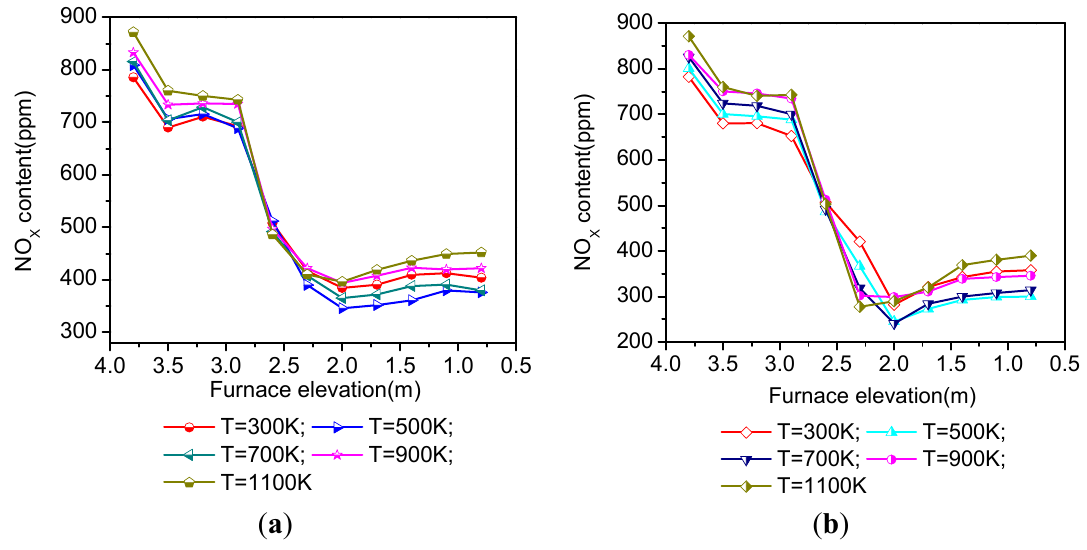
Figure 11. NO x distributions along with the height of the furnace at different secondary air temperatures: ( a ) SAm reburning; and ( b ) cornstalk